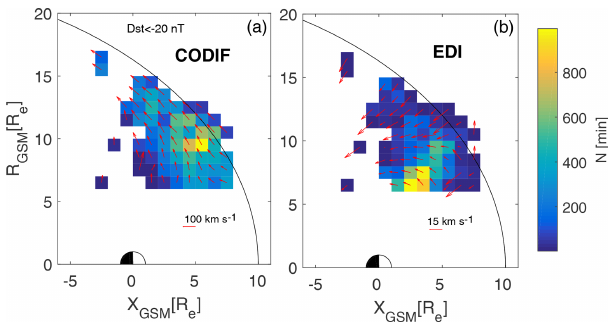
Figure A3. Distribution of average parallel and convection veloci- ties in the cusps and plasma mantle regions for active geomagnetic conditions. Labels are the same as in Fig.